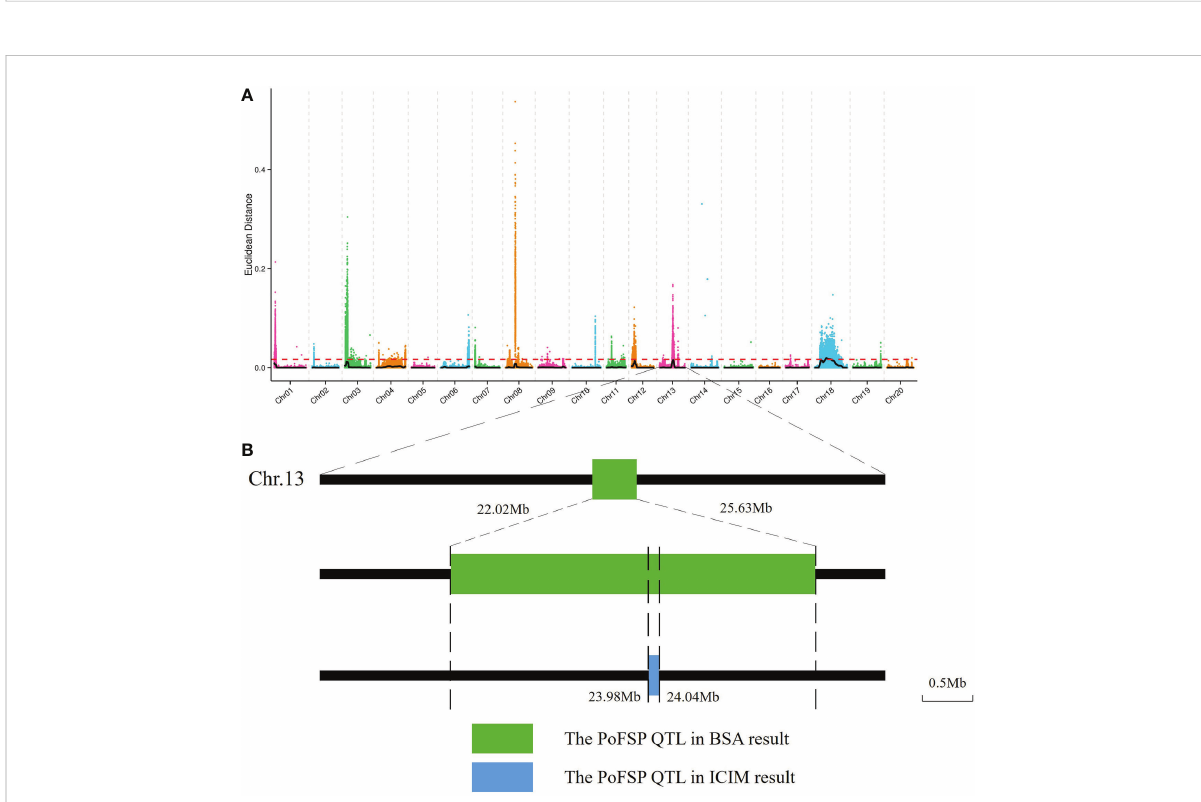
FIGURE 3 BSA results. (A) : The distribution of Euclidean distance (ED)-associated values on chromosomes. (B) : Preliminary mapping process of QTLs for PoFSP. a : The abscissa is the chromosome name. The color points represent the ED value of each single nucleotide polymorphism (SNP) locus. The black line is the fi tted ED value, and the red dotted line represents the signi fi cantly associated threshold. The higher the ED value is, the better the